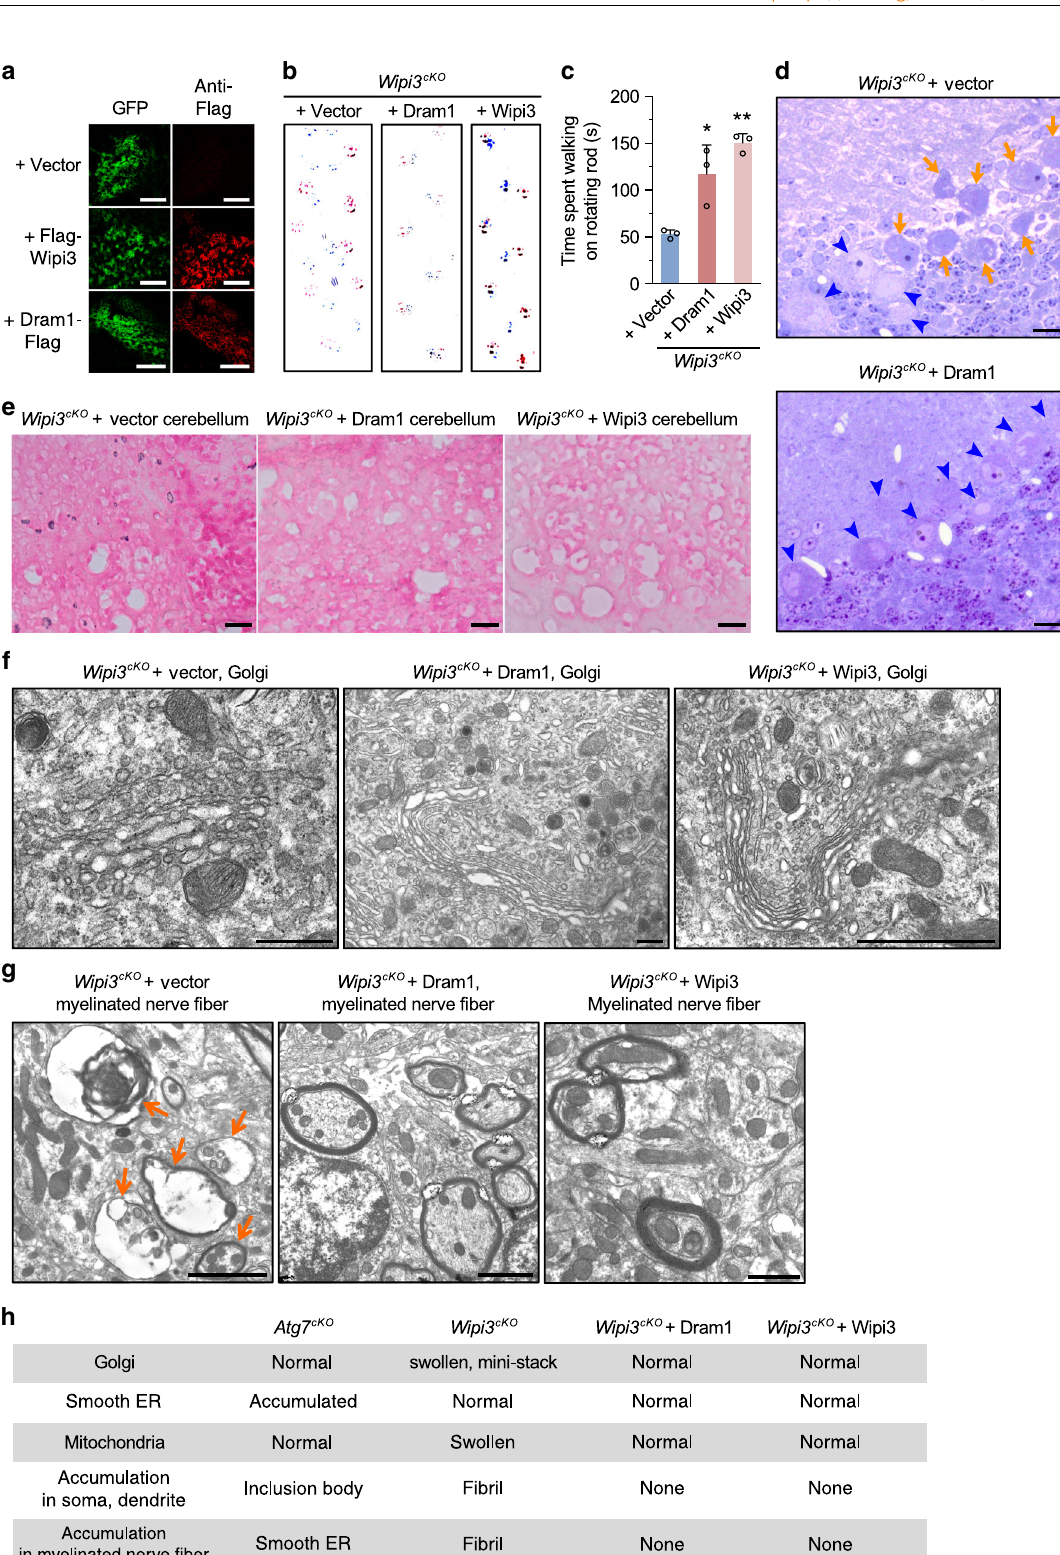
Methods Reagents . The following antibodies were used for the immunoblot and immu- no fl uorescence assays: anti-GFP (Santa Cruz Biotechnology, #sc-9996), anti-Wipi3 (Thermo Fisher Scienti fi c, #PA5-50864), anti-Atg5 (Sigma, #A0731), anti-Lamp2 (Abcam, #ab13524), anti-RFP (MBL, #M204-3), anti-Flag (MBL, #PM020), anti- HA (Santa Cruz Biotechnology, #sc-7392), anti-Lamp1 (abcam, #ab24170), anti- VSVG (KeraFAST, #EB0010), anti-GS28 (BD, #611184), anti-GM130